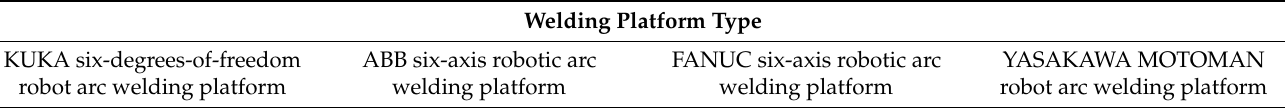
Table 2. Types of main robot welding platform.